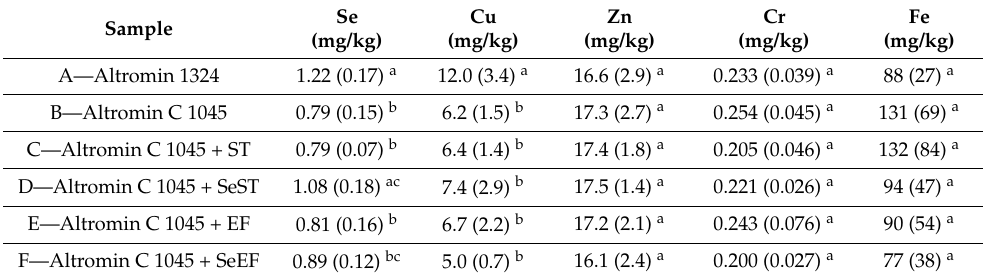
Table 6. Total contents of the elements in rat kidneys (mg/kg wet weight, n = 8). The averages marked by the same letter do not significantly differ at p < 0.05 within the individual columns; data are presented as the mean (standard deviation).